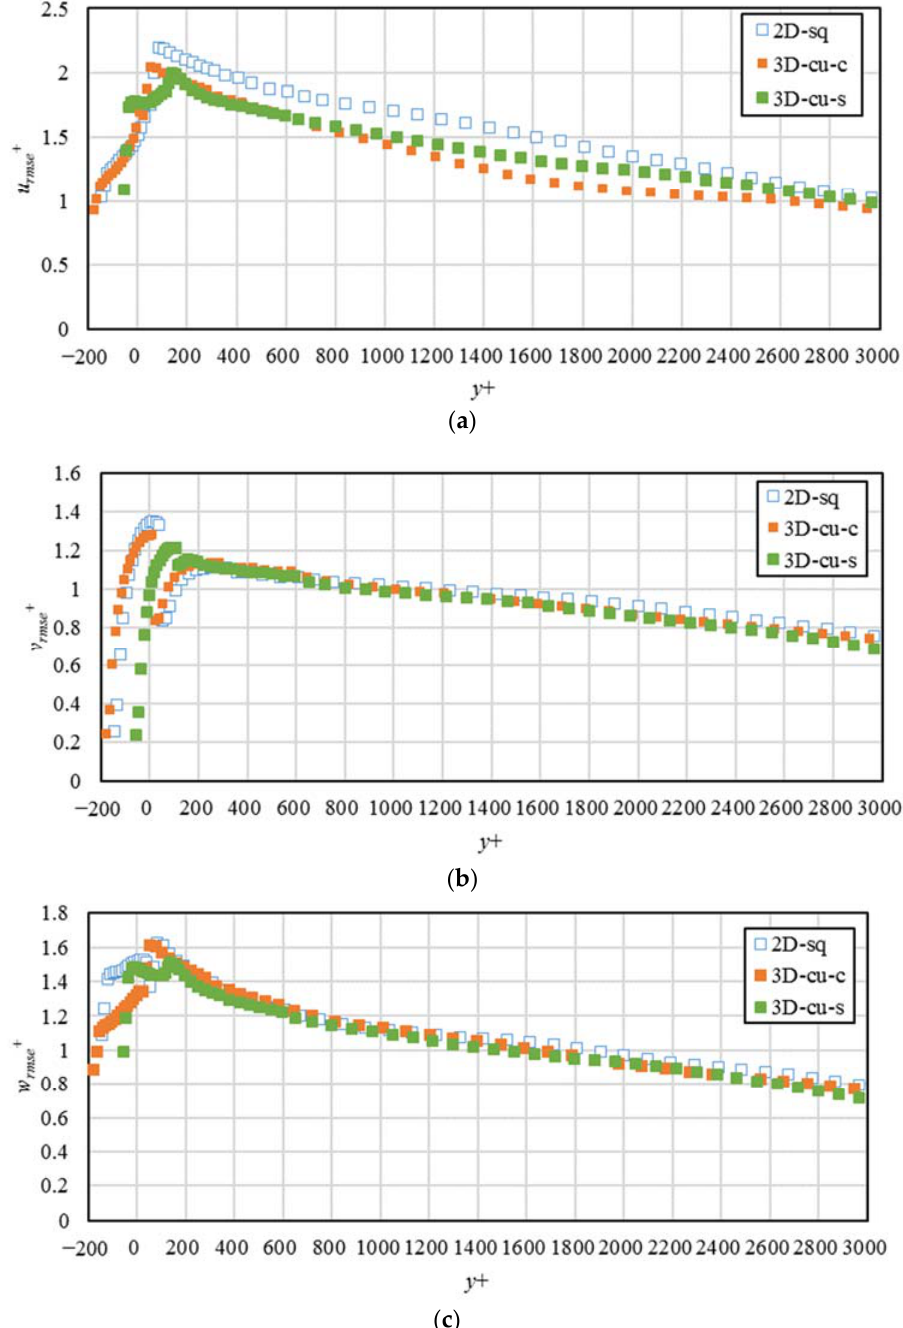
Figure 10. Normalized ( a ) u rmse , ( b ) v rmse , and ( c ) w rmse profiles. Volino et al. suggested that the complete obstruction over the channel width in two- dimensional cases forces flow detachment and acceleration over the bars and leads to a larger k s / d and vertical range affected by the rough wall [23,37]. The complete blockage in the lateral direction forces the flow to go over the roughness bars, offsetting the position of the maximum time-averaged shear stress away from the wall [23]. This phenomenon was also observed in this study, as 2D-sq had the largest 𝑢 ∗ , k s / d , and u rmse + . Comparatively, a horizontal flow around the roughness elements was allowed for the typical three-di- mensional 3D-cu-s case, where uniform distributions of the horizontal velocity (both time- averaged values and their fluctuations) were found in the element roughness layer. With regard to 3D-cu-c, the top surface drag of the roughness element forced its upstream flow to its two side cavities by going over the corner connections, although the chessboard- arranged roughness elements let no interstices between them. As a result, the flow in the roughness element layer was similar to 2D-sq, while the flow over the roughness element was similar to 3D-cu-s. The overlapping of the u rmse + , v rmse + , and w rmse + profiles in the roughness element layer was another consequence of the roughness elements’ blockage effect in each direction. In 2D-sq and 3D-cu-c, the arrangements of the roughness elements cut off the continuous longitudinal flow in the roughness element layer, which limited the longitudinal velocity fluctuations. In contrast, the arrangement of the roughness elements in 3D-cu-s allowed fewer limitations to both the longitudinal and lateral flow, resulting in a higher u rmse + than 2D-sq and 3D-cu-c and a similar w rmse + as 2D-sq in the roughness element layer, where flow in the lateral direction was also less limited. 3.2. Quadrant Analysis for Shear Stress The scattered points on the u’-v’ plane representing the type A and B locations each formed an elliptic cloud, and based on the number of the points that formed the cloud, the joint probability density function (PDF) of u’ and v’ can describe the probability dis- tribution of fluctuations in each quadrant [38]. Here, 2D-sq is taken as an example and the joint PDF contours were calculated and are displayed in Figure 11. The major axes of the elliptic clouds and hyperbolas of the average shear stress are also plotted. On the u’-v’ plane, the points of shear stress were mainly distributed in Q2 (36.38% in type A and 32.31% in type B) and Q4 (24.79% in type A and 36.05% in type B), with a stronger magni- tude than the Q1 and Q3 fluctuations, indicating the dominance of the ejection and sweep event. The fluctuations in these two quadrants had positive contributions to the shear stress – u’v’ , and for all three cases, the Q2 and Q4 fluctuations dominated and their total proportion in the type B points was higher than in the type A points, resulting in a higher average shear stress magnitude in the type B points. Table 3 provides the proportion of